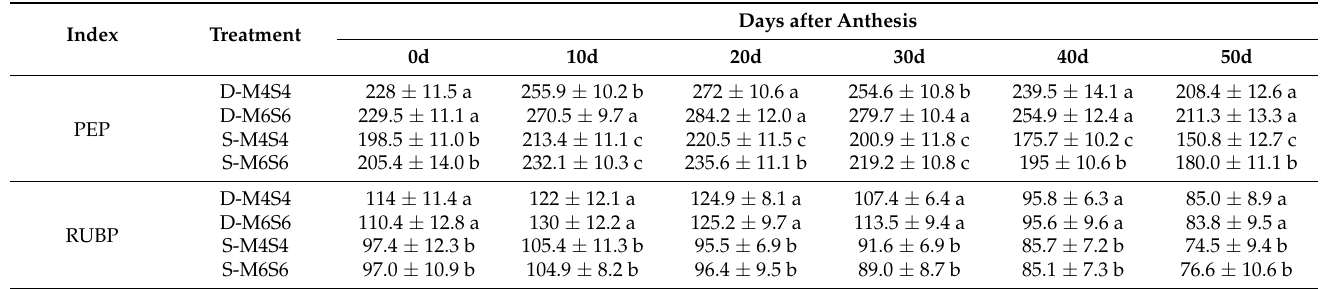
Table 3. Effect of planting pattern and row spacing on the activity of key enzymes in maize ear